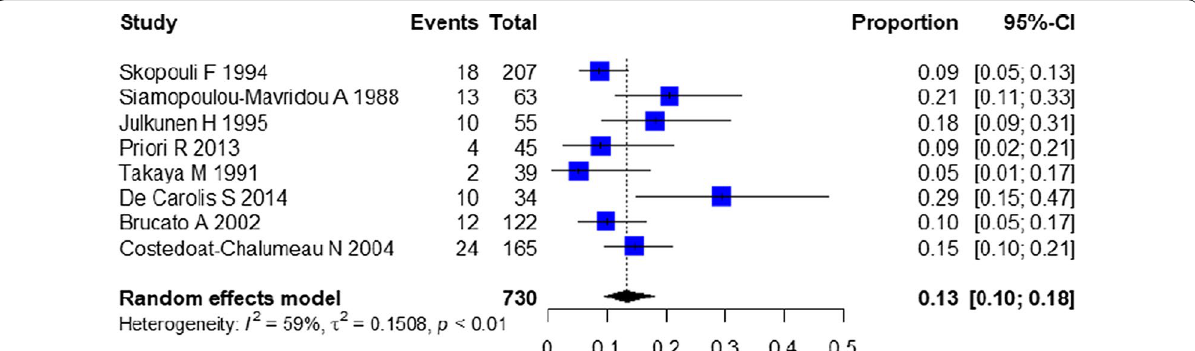
Fig. 6 Meta‑analysis of the incidence of spontaneous abortion in women with Sjogren’s syndrome or rheumatic diseases with reactive anti‑SSA/Ro antibodies during pregnancy